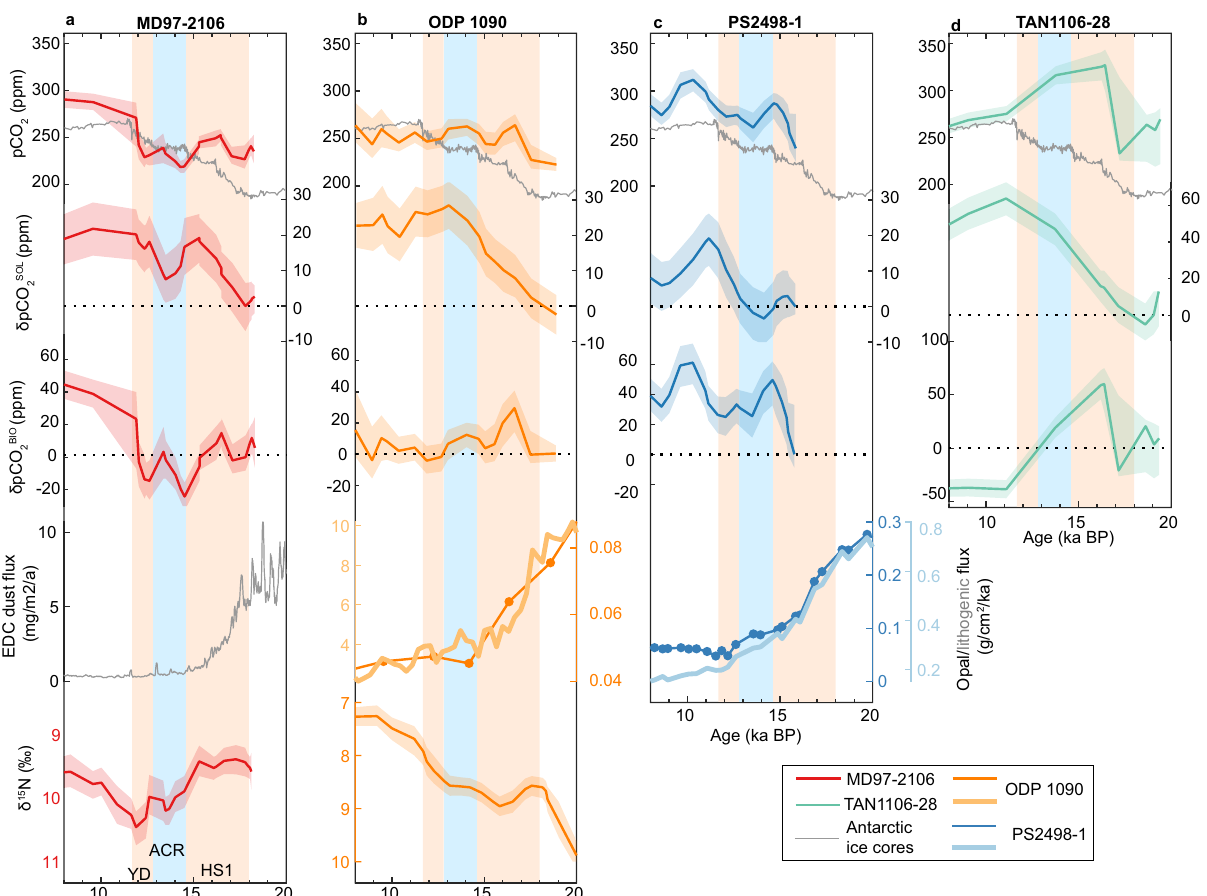
d compared to a – c . Envelopes represent 15.9 – 84.1% uncertainties incorporating uncertainties from measurements, all individual parameters required for calcula- tions, and age models. The vertical pale orange bars represent Heinrich Stadial 1 (HS1; ~18.0 – 14.6 ka BP) and the Younger Dryas (YD; ~12.8 – 11.7 ka BP). The vertical pale blue bar represents the Antarctic Cold Reversal (ACR; ~14.6 – 12.8 ka BP). The reference age for relative surface-water pCO 2 change decomposition at these sites